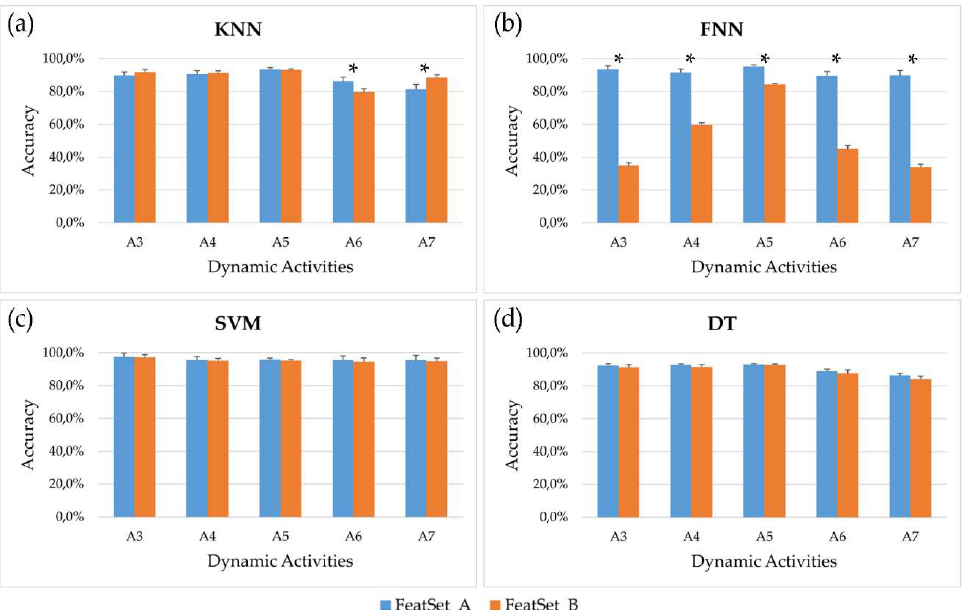
Figure 3. Mean accuracy (bar) and standard error (whisker) across the 61 subjects involved in the